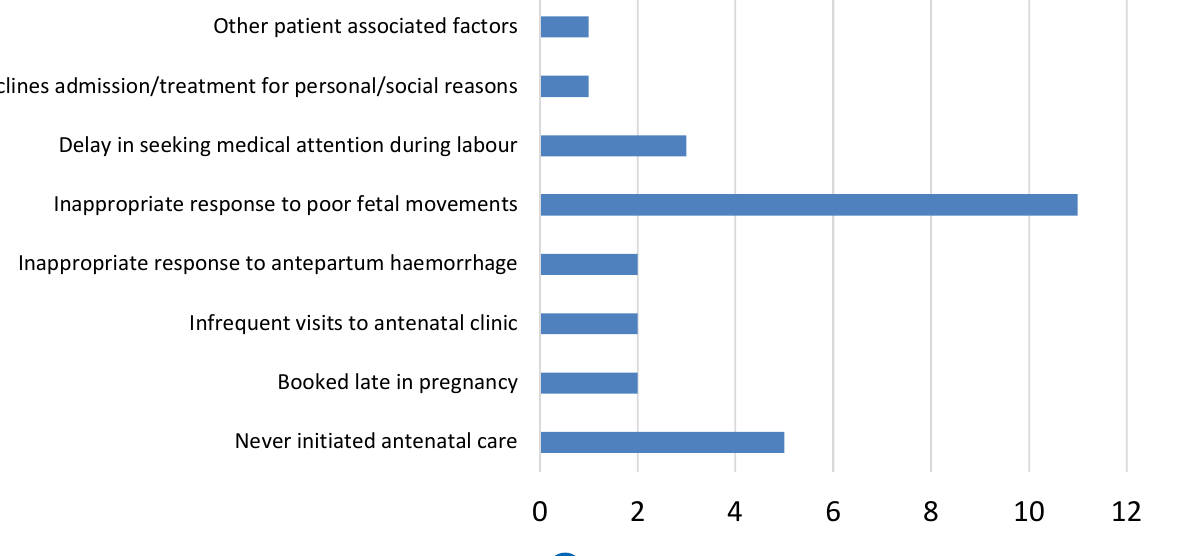
Figure 1: Patient-associated modifiable factors identified during the stillbirth audit